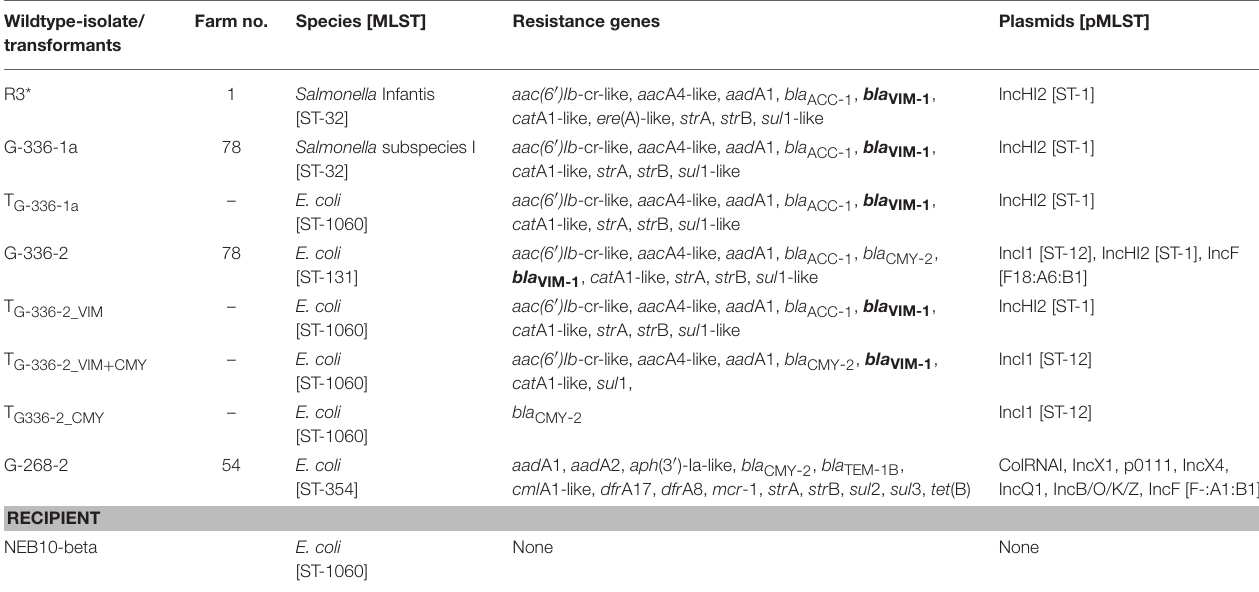
TABLE 1 | Characteristics of carbapenem-resistant E. coli and S. Infantis isolates including their respective transformants derived from whole genome data analyses. Wildtype-isolate/ Farm transformants